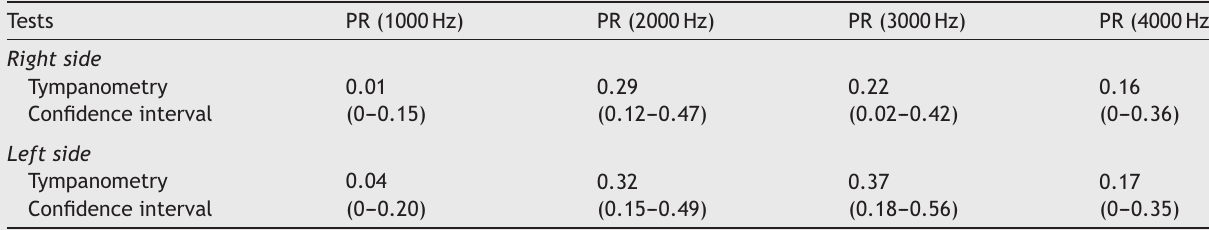
Agreement between tympanometry and PR exams in 105 newborns evaluated.